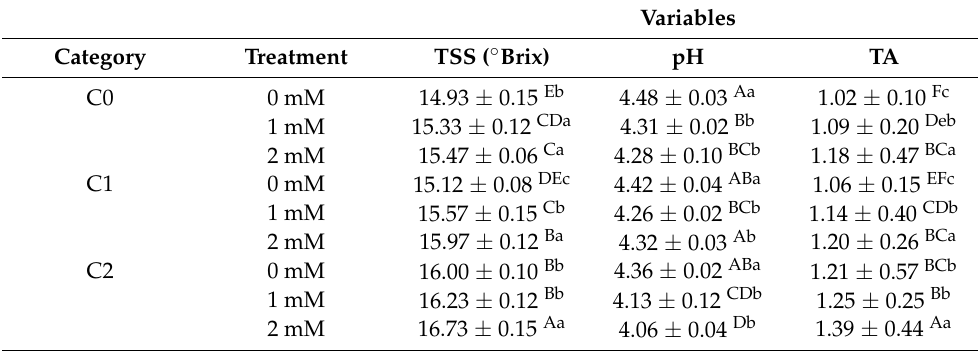
Table 4. Changes in total soluble solids (TSS), pH, and titratable acidity (TA) in cracking categories of fig flesh after preharvest treatment with different concentrations of salicylic acid (SA), in year 1. Categories: C0, sound fruit; C1, slightly cracked; C2, highly cracked.